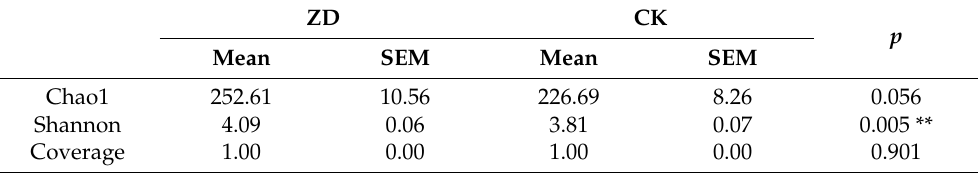
Table 3. Alpha diversity indices between zinc-deficient group and control group.